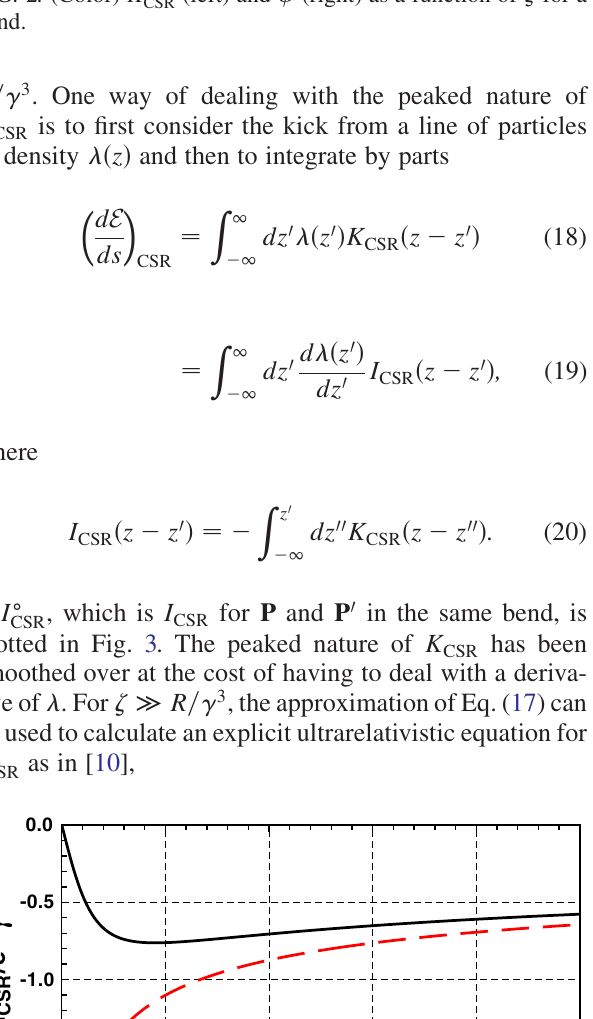
(left) and (cid:6) (right) as a function of (cid:5) for a CSR